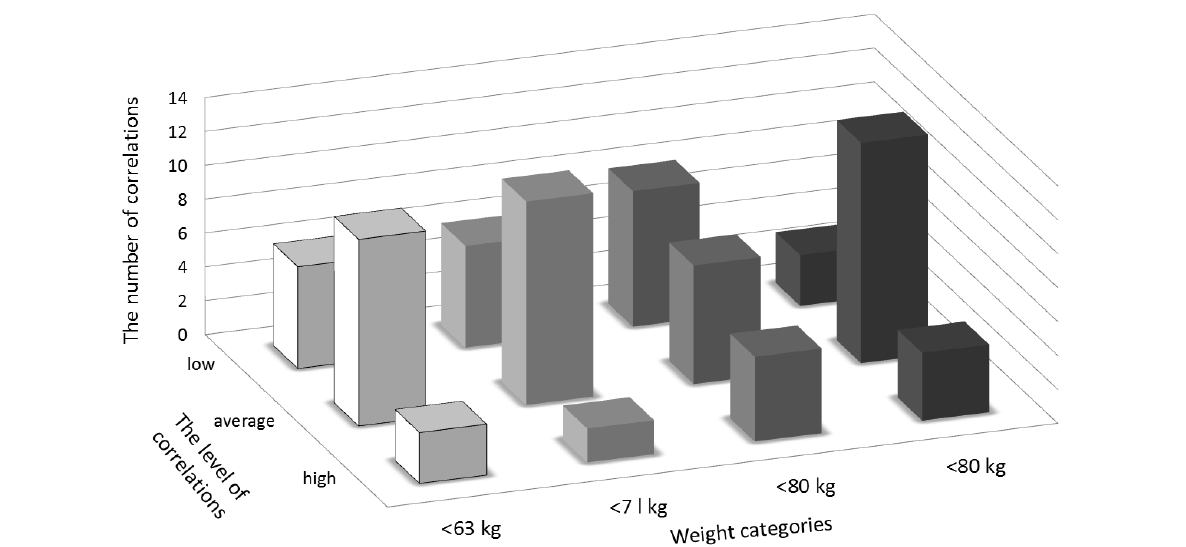
Fig. 2. The structure of correlations between somatic characteristics and the training experience among highly qualified taekwon-do ITF